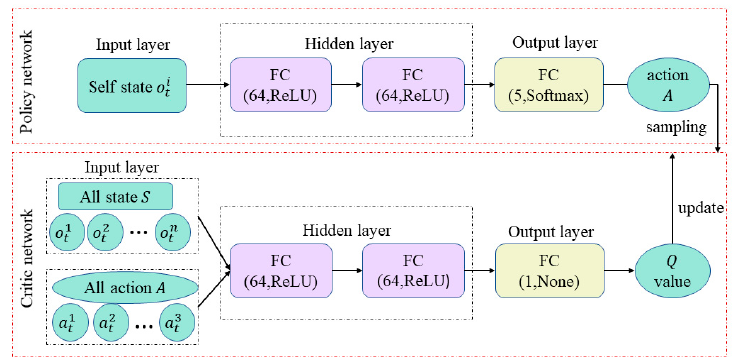
Figure 5. Multi-agent interactive learning network map.